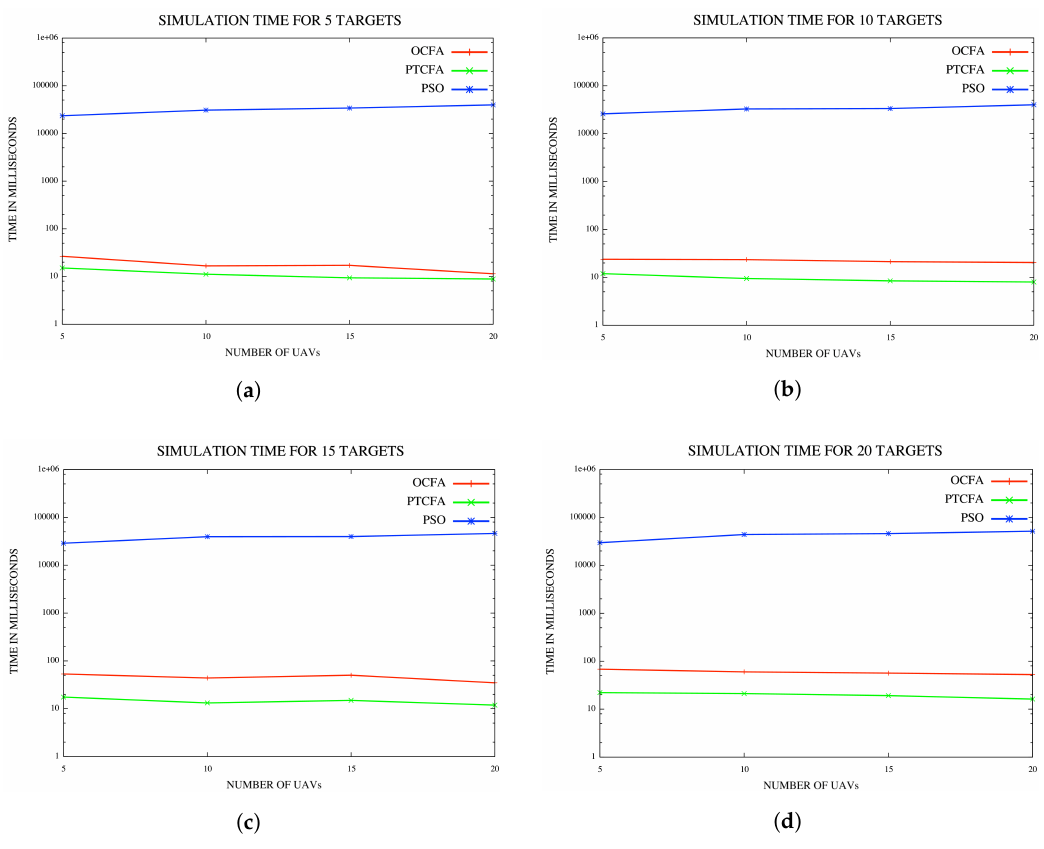
Figure 14. ( a ) Simulation time for five targets/locations; ( b ) simulation time for 10 targets/locations; ( c ) simulation time for 15 targets/locations; ( d ) simulation for time 20